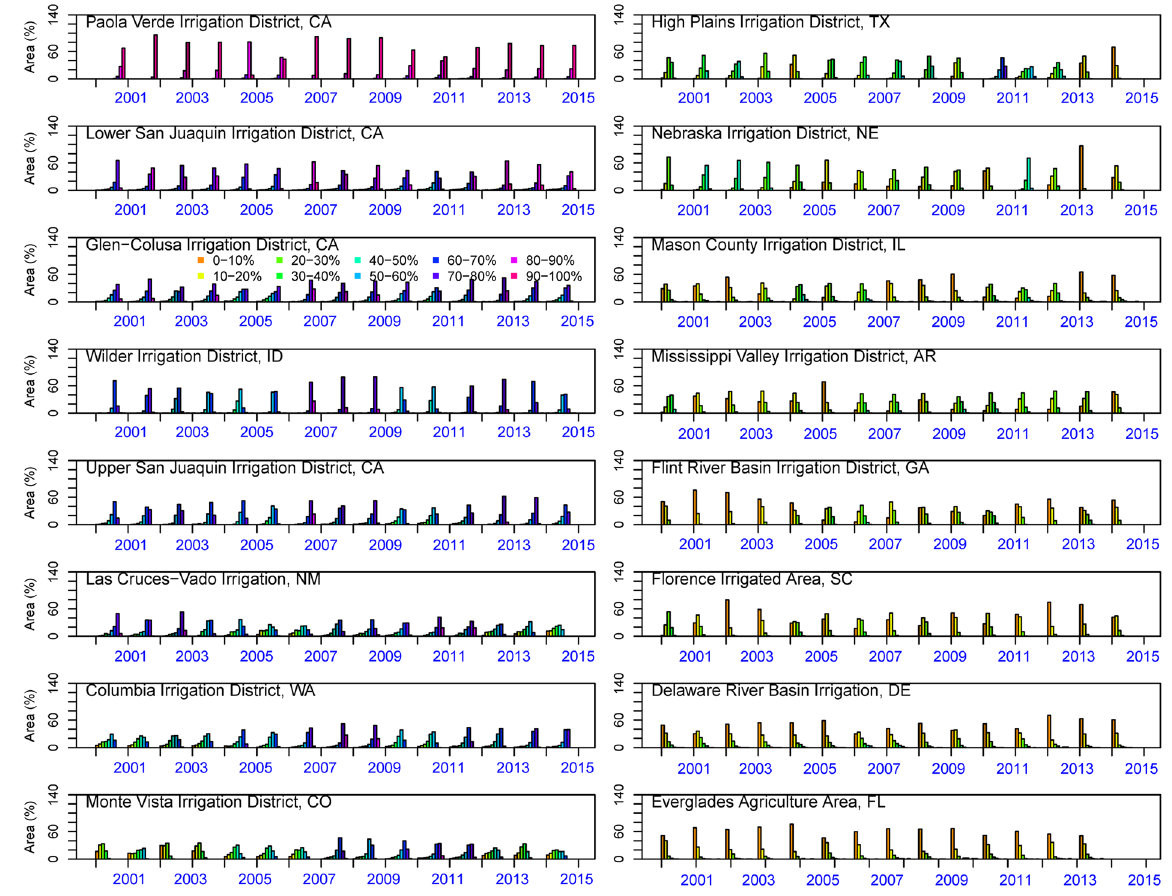
Figure 5. Spatial variability in the BWET: frequency distribution of irrigated landscapes with different categories of BWET percent summarized for 16 different irrigated areas across CONUS. The figure was generated using R 3.3.0 software